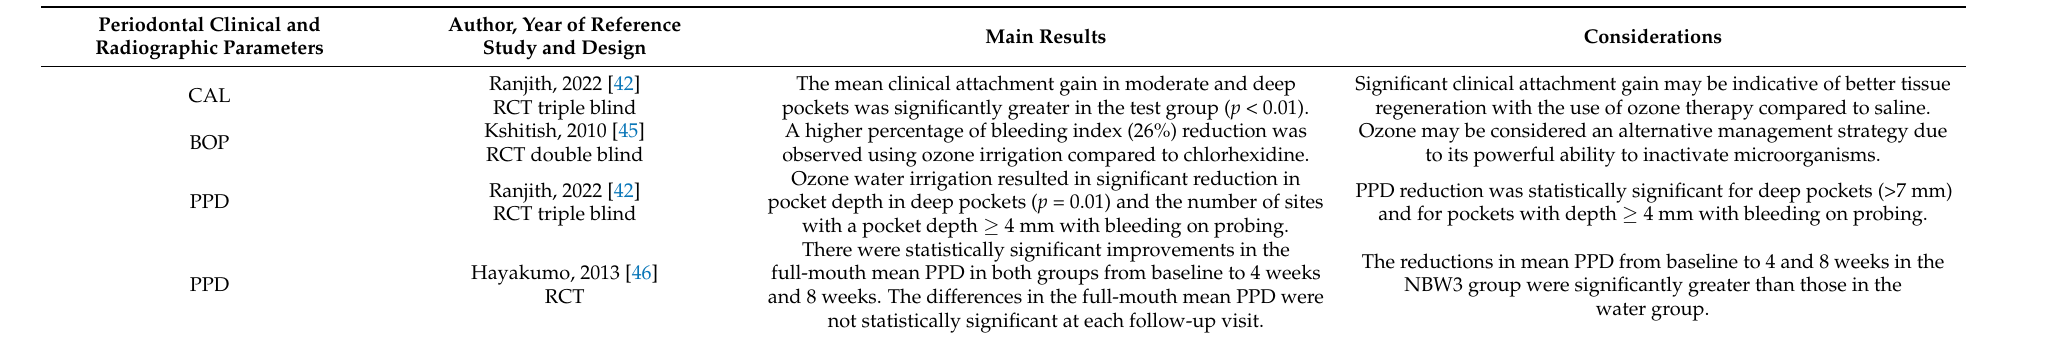
Table 4. Characteristics of the periodontal clinical, radiographic and inflammatory parameters for ozonate water, including clinical attachment loss (CAL), probing depth (PPD), bleeding on probing (BoP), plaque index (PI), gingival index (GI), marginal bone levels (MBL), Interlukine-1b (IL-1b) and periodontal treatment with Scaling and Root Planing